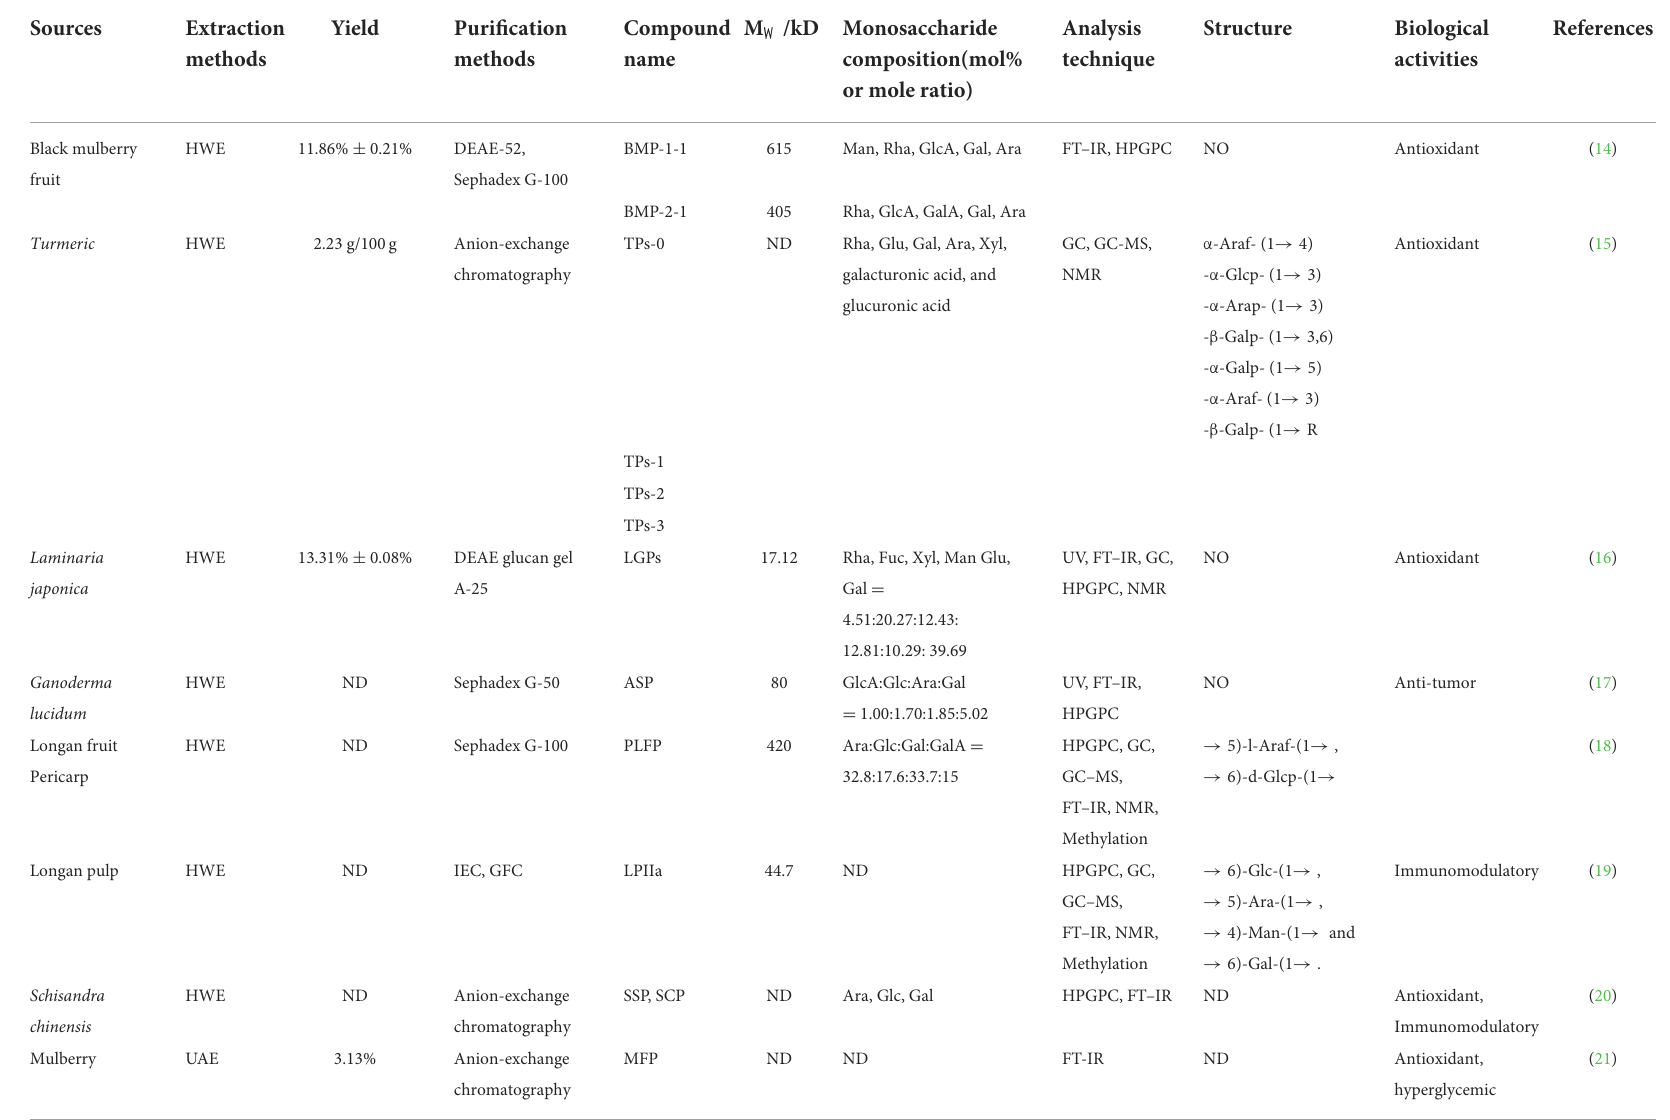
TABLE 1 Extraction, purification, structural characterization, biological activities of polysaccharides from traditional Chinese